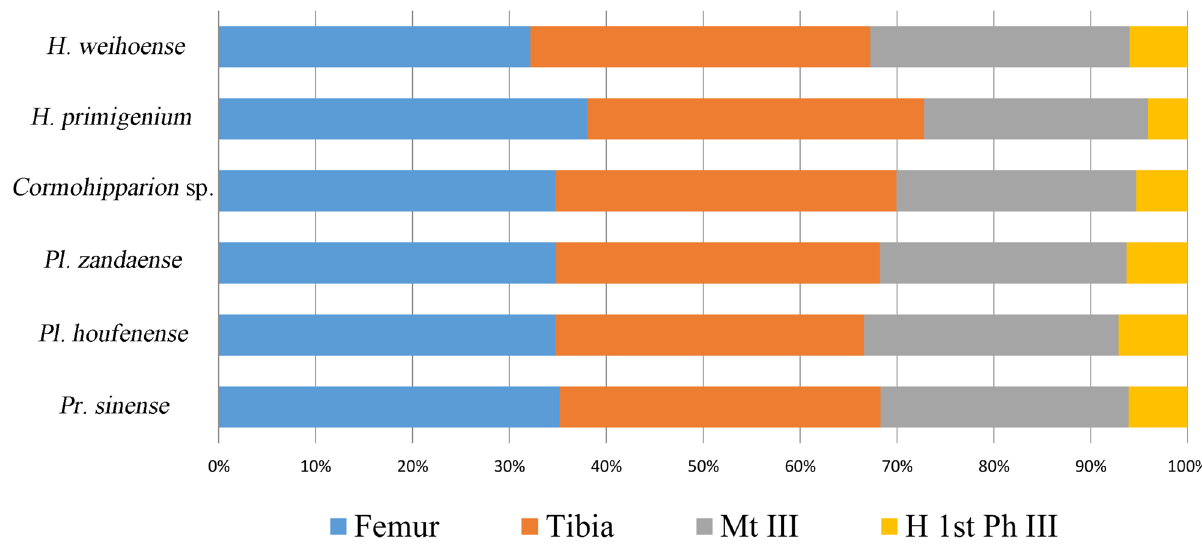
Figure 3. Proportions of hind limb bones in H . weihoense and other equids (generated with Microsoft Excel version 2010 by B. Deng 36 proposed that environments were more open since the Late Miocene in the Linxia Basin, represented by the Guonigou and Dashangou faunas. These open habitats were located in the area surrounding the Tibetan Plateau, and H. weihoense had adapted to live in them at 11.5 Ma. Dettman et al. 40 also confirmed that the period of greatest aridity at the NE margin of the Tibetan Plateau was from 9.6 to 8.2 Ma, correlative to the age of the Dashengou fauna in the Linxia Basin, which is highly consistent with other climate records 37,38 . This was the age